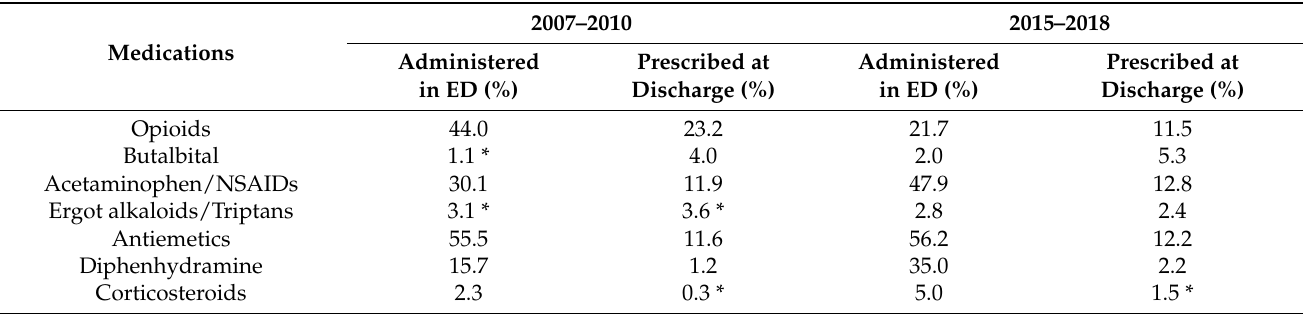
Table 4. Frequency of medication use stratified by those administered in ED and prescribed